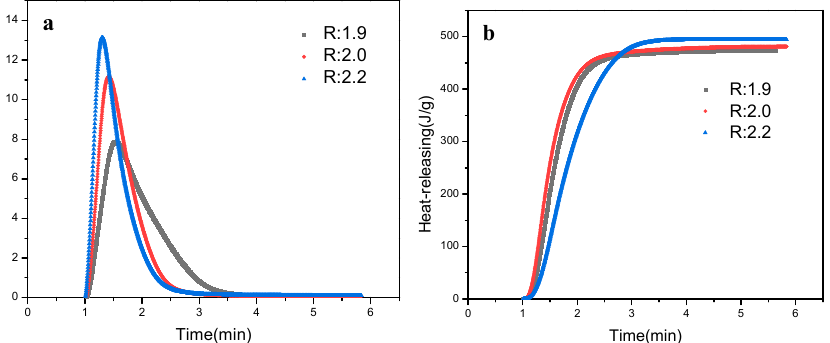
R-value effect on photo-polymerisation performance of PU-TiO 2 ink: ( a ) photo-polymerisation rates, ( b ) heat releasing.